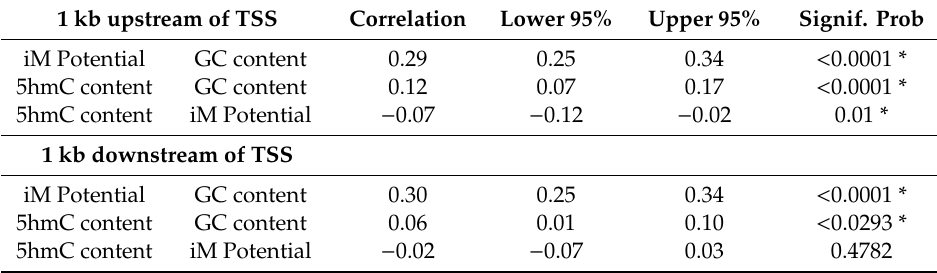
2.3. Putative G4/iMs Enriched with 5hmC are Primarily Found in Differentiation and Proliferation Genes